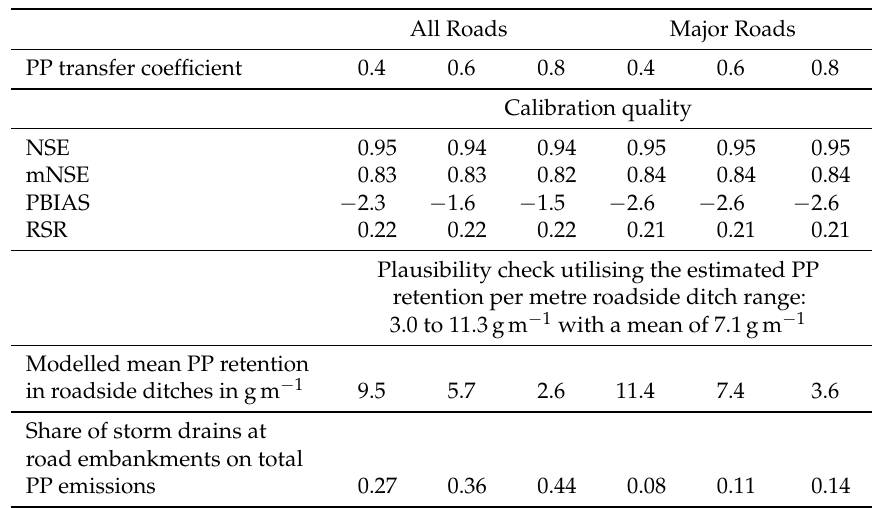
Table 3. Modelled shares of storm drains at road embankments on total PP emissions including the calibration quality of the six modelled scenarios and plausibility check of the chosen PP transfer coefficients in roadside ditches utilising the estimated PP retention per metre roadside ditch range. The closer the values of the modelled mean PP retention in roadside ditches and the mean estimated PP retention per metre roadside ditch range for a given transfer coefficient scenario are, the more plausible we consider the